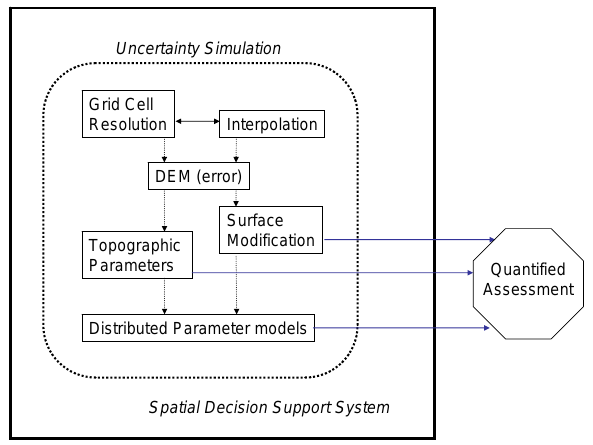
Fig. 3. Spatial model of a DEM uncertainty SDSS Figure 3 : Spatial model of a DEM uncertainty SDSS toolbox